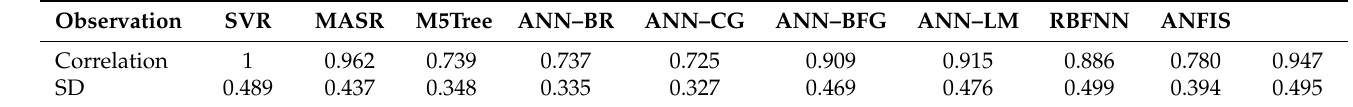
Figure 17. Distribution of error with CVD data using ANN–BR ( a ), ANN–CG ( b ), ANN–BFG ( c ) and ANN–LM ( d ) approaches; see abbreviations in Nomenclature. Table 9. The correlation and SD of the true and predicted data of ML models; see abbreviations in Nomenclature.